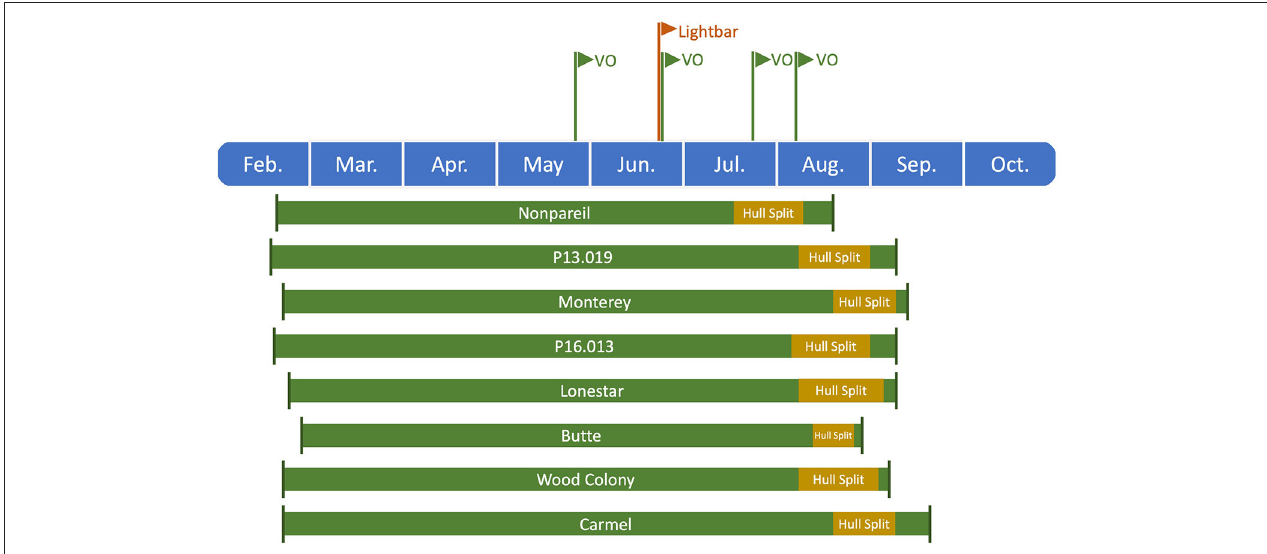
FIGURE 2 | Timeline of the growing season for different almond varieties from full bloom to commercial harvest dates in 2019. All harvest dates were recorded from the experimental orchards, while other dates (i.e., full bloom and hull split) were estimated based on the studies of Connell et al. (2010, 2017) and Lampinen et al. (2017), except full bloom date for ‘Nonpareil’ was also recorded from the experimental orchards.